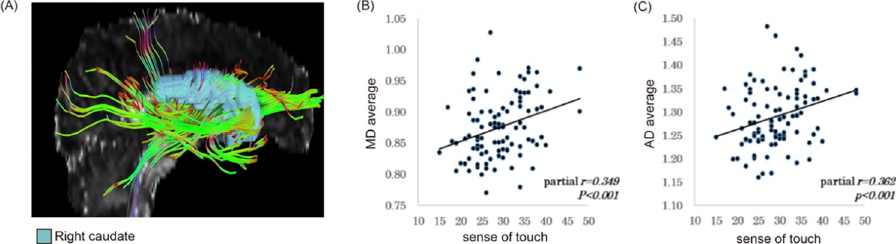
Fig 1. Correlation between the white matter fiber of the right caudate and AASP modality scores. A shows white matter in the right caudate using DSI studio. B shows the correlations between MD of the white matter in the right caudate and the sense of touch score in AASP score (partial r = 0.349, p < 0.001). C shows the correlations between AD of the white matter in the right caudate and the sense of touch score in AASP score (partial r = 0.362, p < 0.001). AD, axonal diffusivity; MD, mean diffusivity; AASP, Adolescent/Adult Sensory Profile.